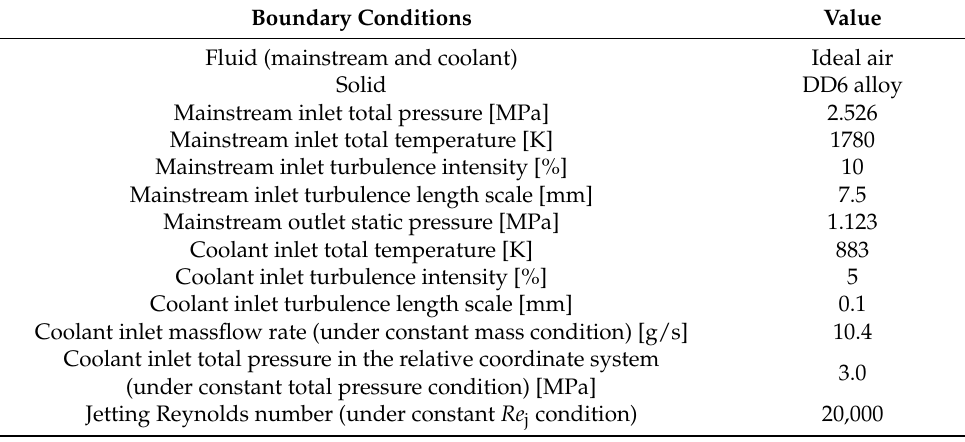
Table 2. Detailed boundary